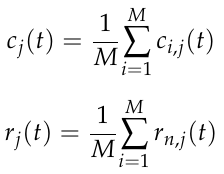
Table 1. Criteria for judging the degree of relevance.